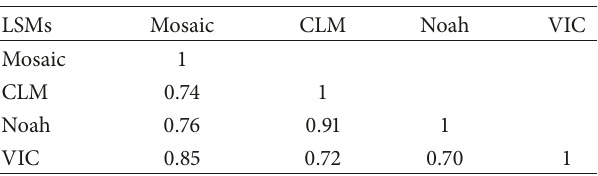
Table 4: Correlation coefficient about SM among different LSMs in the Huang-Huai-Hai Plain. LSMs